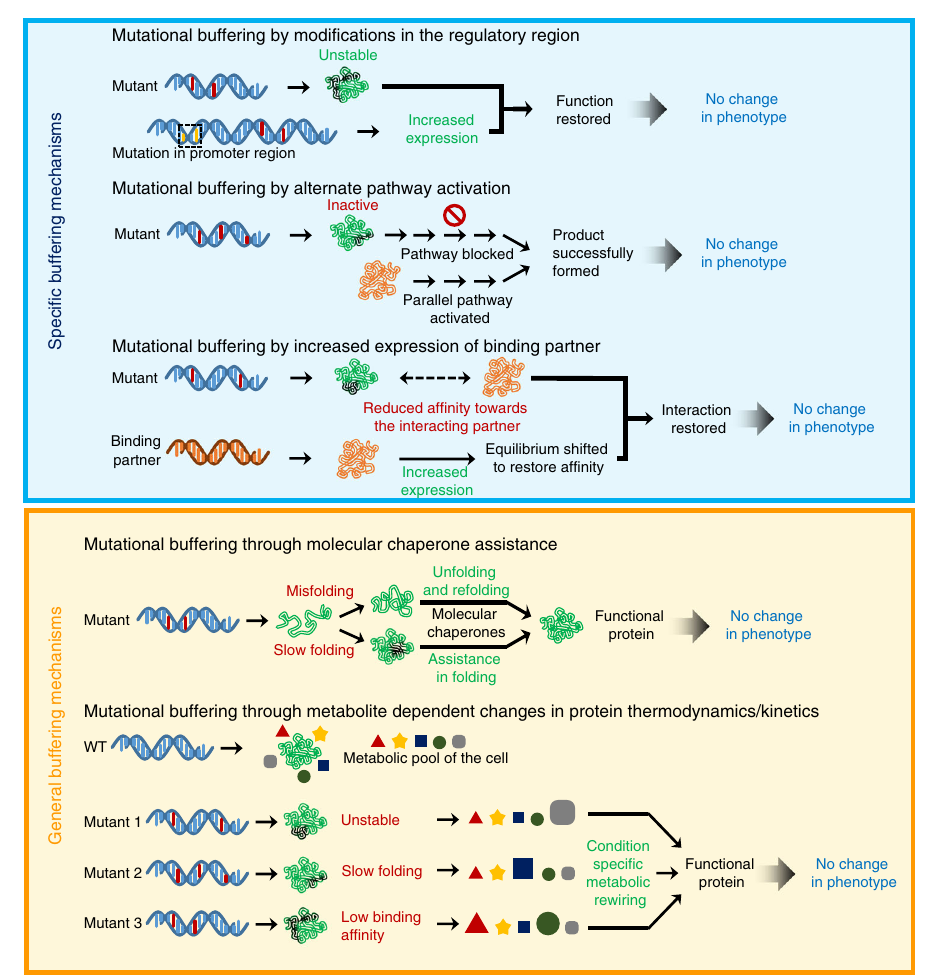
Fig. 1 Schematic showing speci fi c and general buffering mechanisms. Mutational buffering in a cell can be achieved by modi fi cations in the regulatory region of a substrate leading to its increased expression, activation of alternate pathways or by increased expression of the binding partner for a speci fi c substrate (top panel). However, generalized buffering of mutant phenotypes is executed by protein folding assistance through molecular chaperones or through relative composition and concentration of metabolite and resultant changes in protein thermodynamics and kinetics (bottom